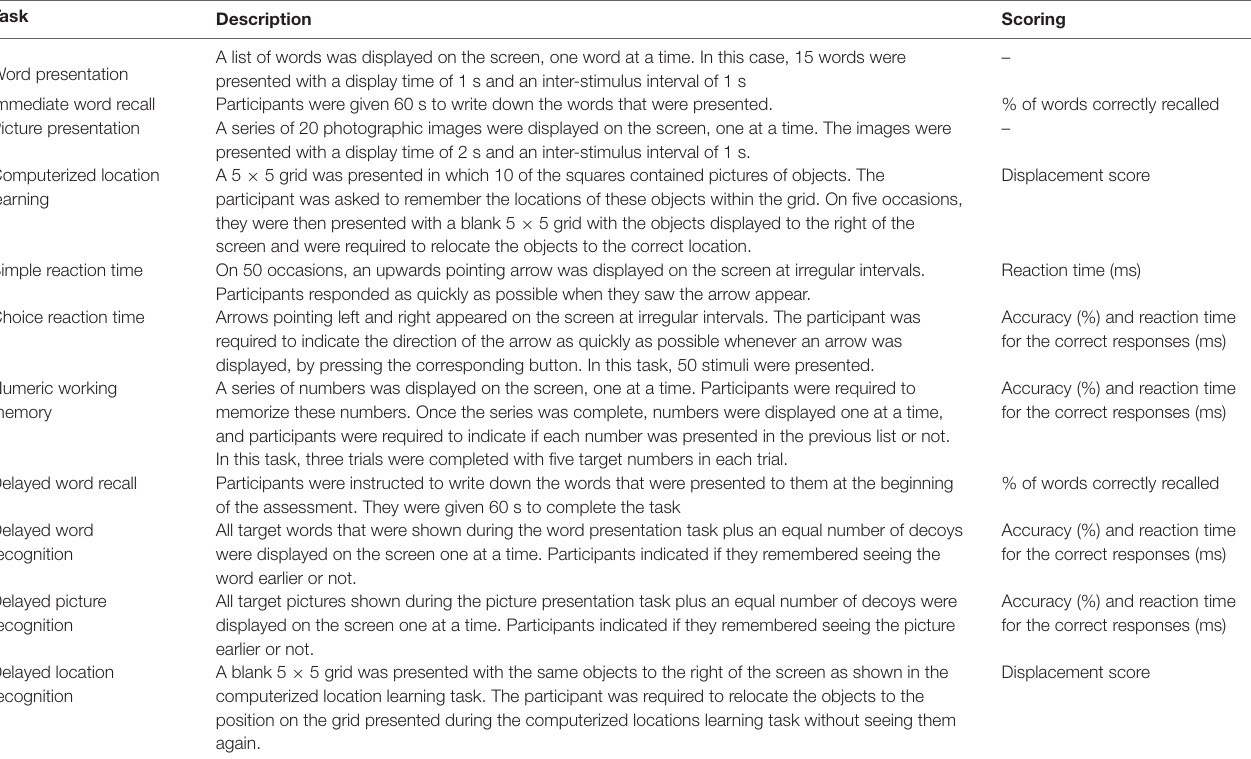
TABLE 1 | COMPASS tasks